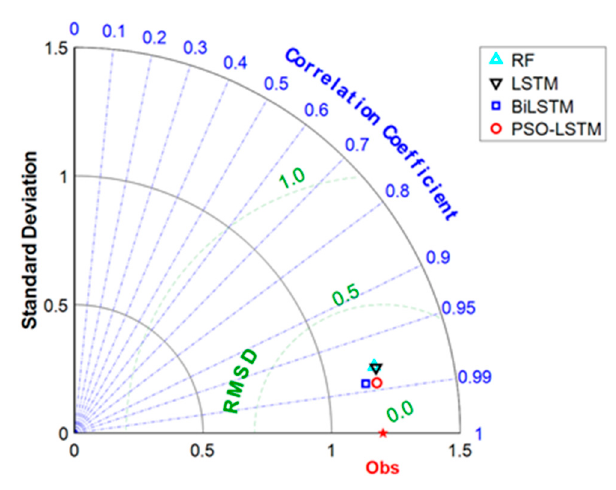
Figure 9. Comparison of the monthly average runoff simulation results of different models (Taylor diagram).